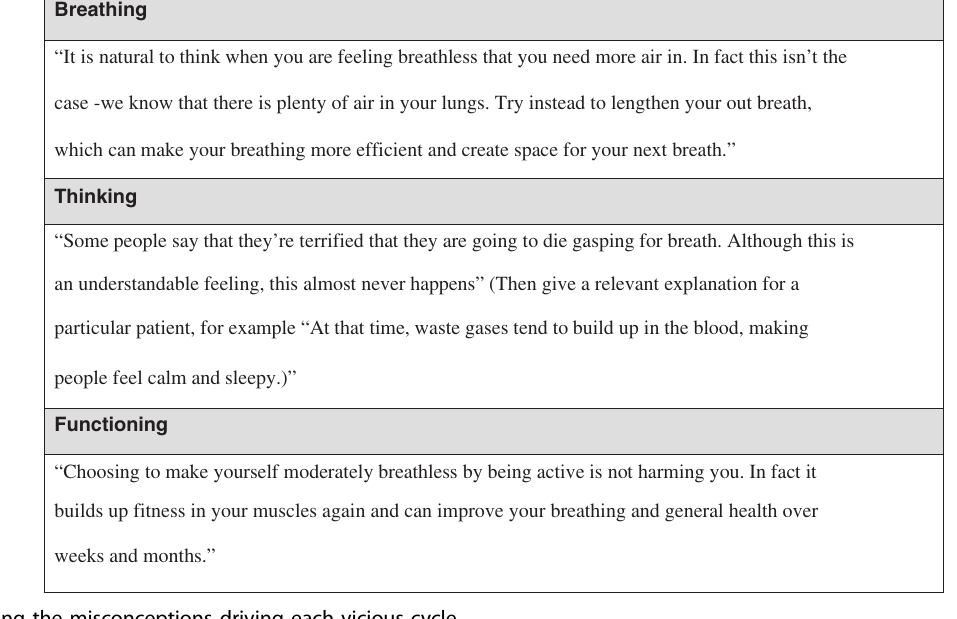
Fig. 2 Challenging the misconceptions driving each vicious